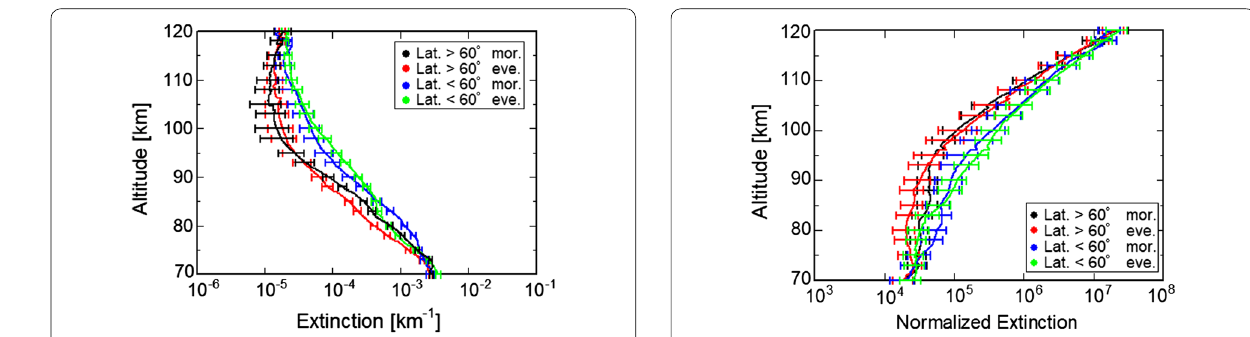
Fig. 6 Average extinction coefficient profiles for morning high‑latitude (latitude > 60 ◦ , black line), evening high‑latitude (latitude > 60 ◦ , red line), morning low‑latitude (latitude < 60 ◦ , blue line), and evening low‑latitude (latitude < 60 ◦ , green line) observations. The average of the variability is 21.5% for the morning high‑latitude observations